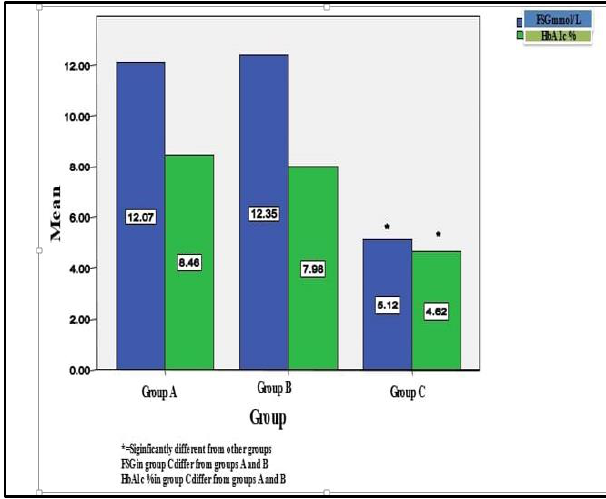
Figure ( 1) Mean values of fasting serum glucose and HbA 1c among groups.